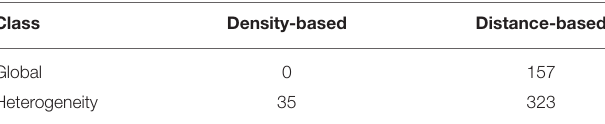
TABLE 2 | Numbers of potentially predictive features in the different classes of